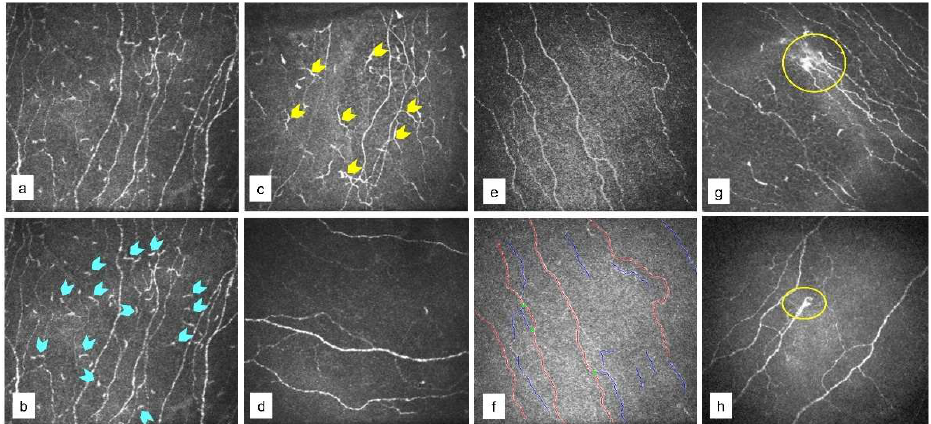
Figure 2. Corneal dendritic cells, microneuroma-like structures, and sub-basal nerve plexus in cornea of study participants. Panels are representative in vivo confocal microscope images showing ( a – c ) corneal dendritic cells, ( d – f ) corneal sub-basal nerve plexus and ( g , h ) microneuroma-like structure indicated within the yellow circle. Immature forms of dendritic cells are shown with blue arrows in ( b ). Mature forms of dendritic cells are indicated with yellow arrows in ( c ). The blue and red lines shown in ( f ) indicates CC metrics software detection of the nerves to determine the various morphological parameters.